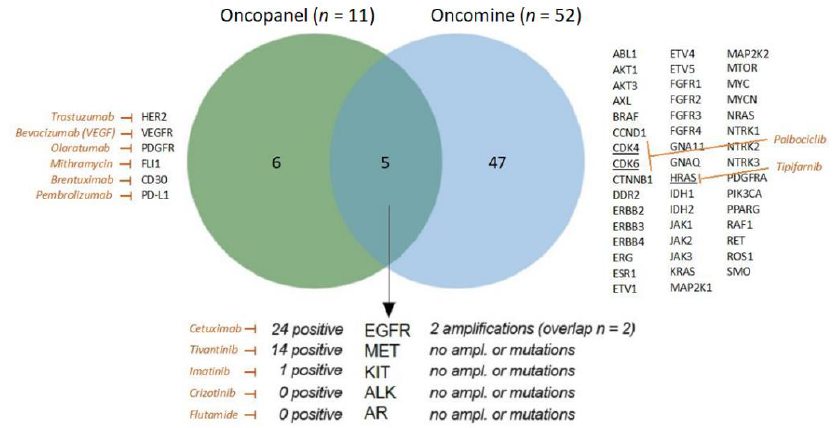
Figure 3. Overlapping genes/markers ( n = 5) between the oncopanel ( n = 11) and the oncomine panel ( n = 52) in a Venn diagram. The results for the overlapping markers are displayed at the bottom. On the sides, a table shows the remaining genes/markers for each table. A selection of possible targets is marked with an example of targeted treatment.